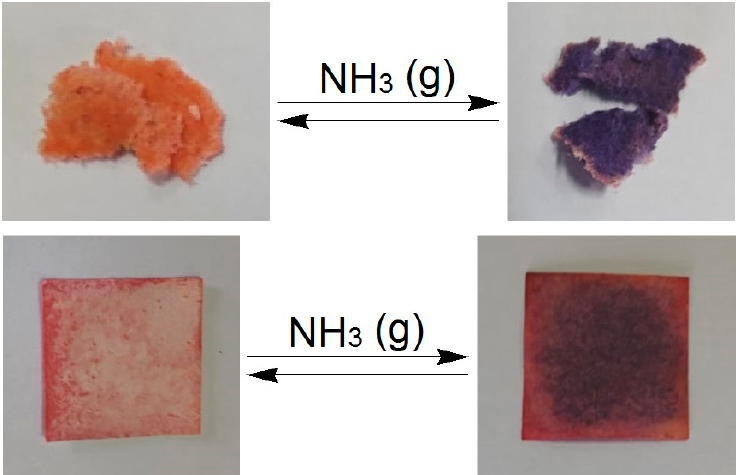
Figure 7. Air-dried UTCFH xerogel ( top ) as well as UTCFH xerogel deposited onto a filter paper strip ( bottom ) obtained from DMSO with a total content of TCFH at 0.06 wt% demonstrating a color change from orange to purple upon exposure to gaseous ammonia.